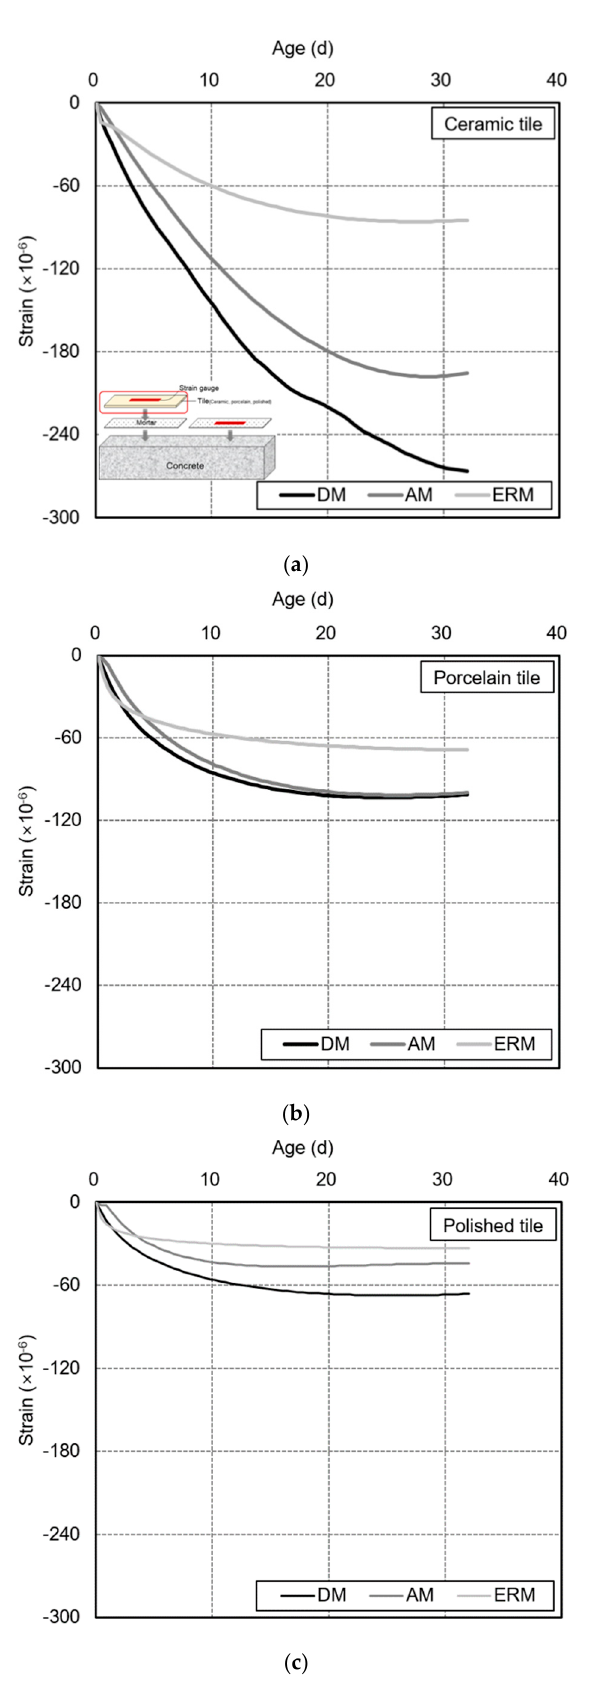
Figure 12. S hrinkage of tile: ( a ) ceramic, ( b ) porcelain, and ( c ) polished. Figure 12. Shrinkage of tile: ( a ) ceramic, ( b ) porcelain, and ( c )